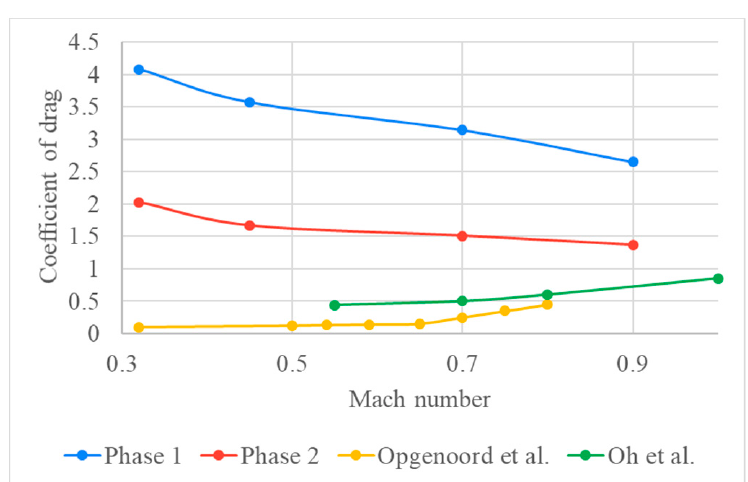
Figure 8. Drag coefficients for the pod models.